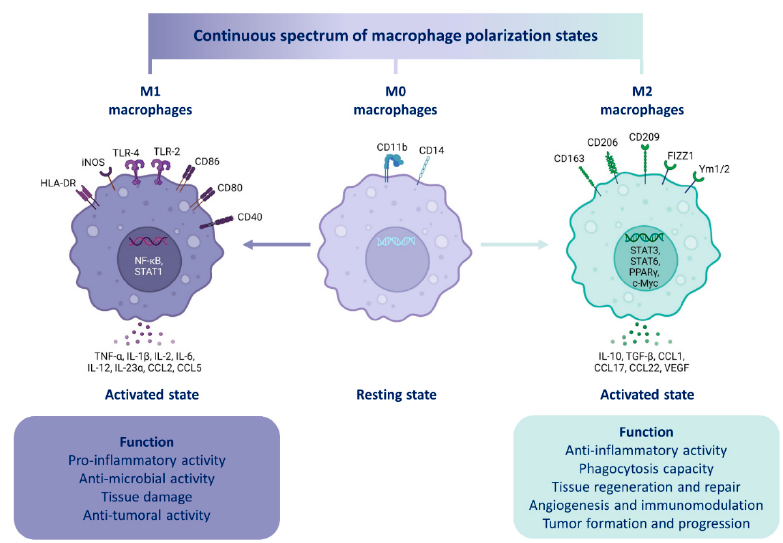
Figure 3. Spectrum of macrophage polarization. Depending on the signals perceived in its milieu (microbial products, damaged cells, cytokines), a naive M0 macrophage can be activated and polarize towards a plethora of different phenotypes. The two extremes of this continuous polarization spectrum are, on the one hand, M1 macrophages, known to have pro-inflammatory activity, and on the other hand, M2 macrophages, known to have anti-inflammatory function. These two extremes were obtained in in vitro models where their polarization markers (such as membrane receptors, transcription factors, cytokines) were identified. However, in vivo, macrophages present in an organism, or in a tumor, will tend towards an M1 or M2 phenotype. Due to the great complexity of the in vivo milieu, these macrophages will never reach the level of polarization that macrophages obtained in vitro. These macrophages in vivo will thus be called M1-like or M2-like [149–152]. Created with BioRender.com.